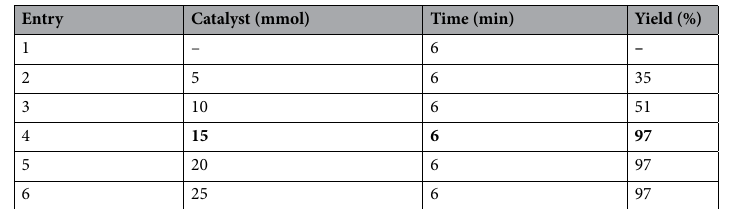
Table 2. Effect of Cr 2 O 3 nanoparticles as nanocatalyst on the synthesis yields of compound 4a . Reaction conditions: Benzaldehyde ( 1a , 1 mmol), AcONH 4 ( 2 , 3 mmol), benzil ( 3 , 1 mmol), and catalyst in H 2 O (2 mL) under microwave irradiation (400 W). Significant values are in bold.